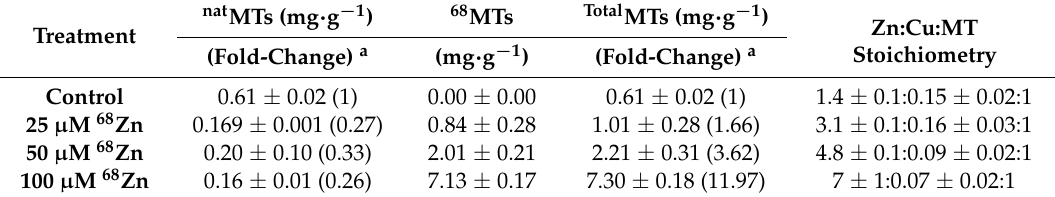
Table 2. Concentration of MTs (in mg of MTs per g of protein) labeled with nat MTs (natural contribution of zinc), 68 MTs (exogenous contribution of zinc) and Total-Zn-MTs (sum of both natural and exogenous contributions), in HRPEsv cells. Cells were cultured for 24 h in the absence (control) or presence of 68 ZnSO µ M). The concentration of MTs containing nat Zn and 68 Zn was determined 4 (at 25, 50 or 100 by ID-,IPD-SEC-ICP-MS. Total protein level (in mg) in HRPEsv cell extracts was determined by BCA assay kit. The elemental stoichiometric composition of the MTs complexes was calculated by the determination of the S to metal (Zn and Cu) ratio, i.e., Zn:Cu:MT.